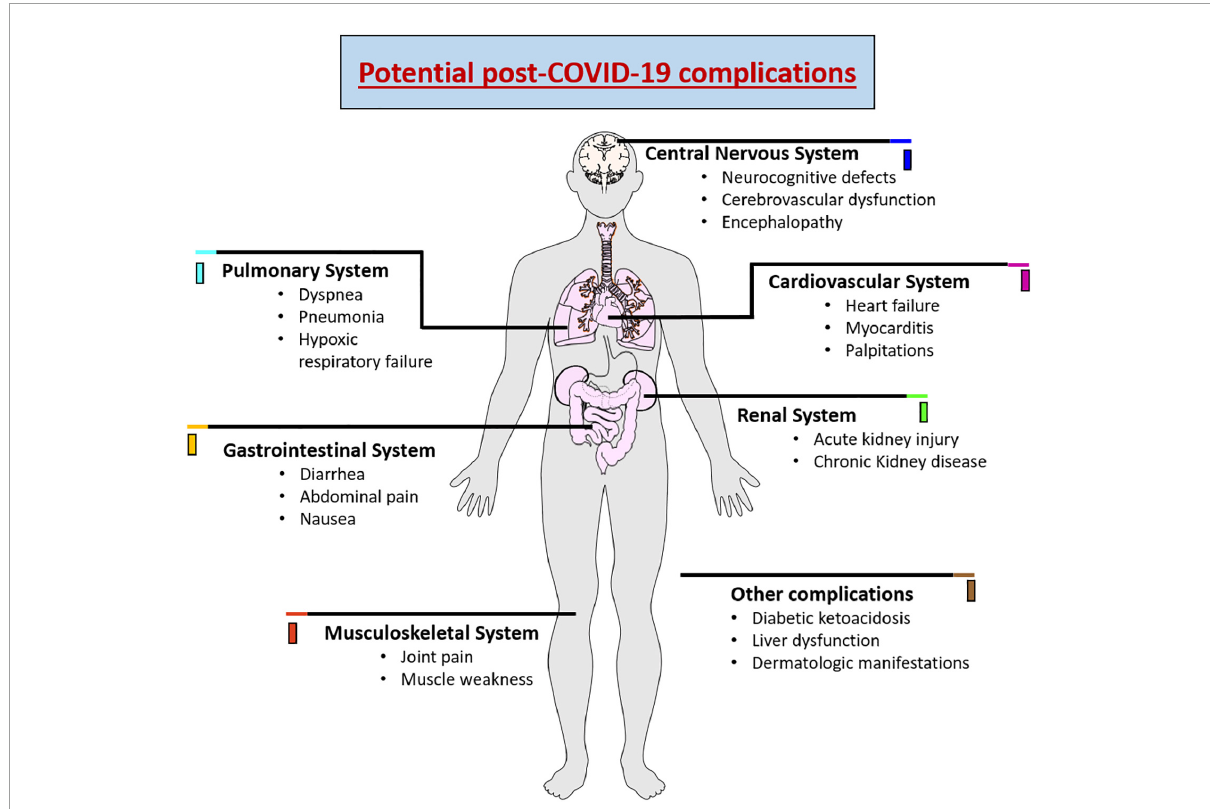
FIGURE1 Schematic representation showing the potential complications of COVID-19 causing wide range of complications in various organ systems.